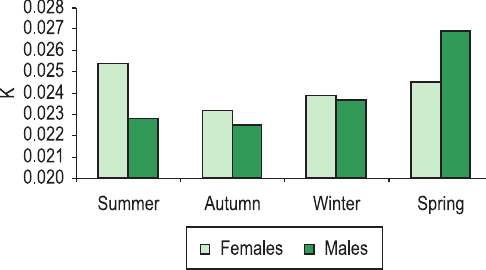
Figure 5. Variation of condition factor (K) of A. fasciatus for both sexes and season year.